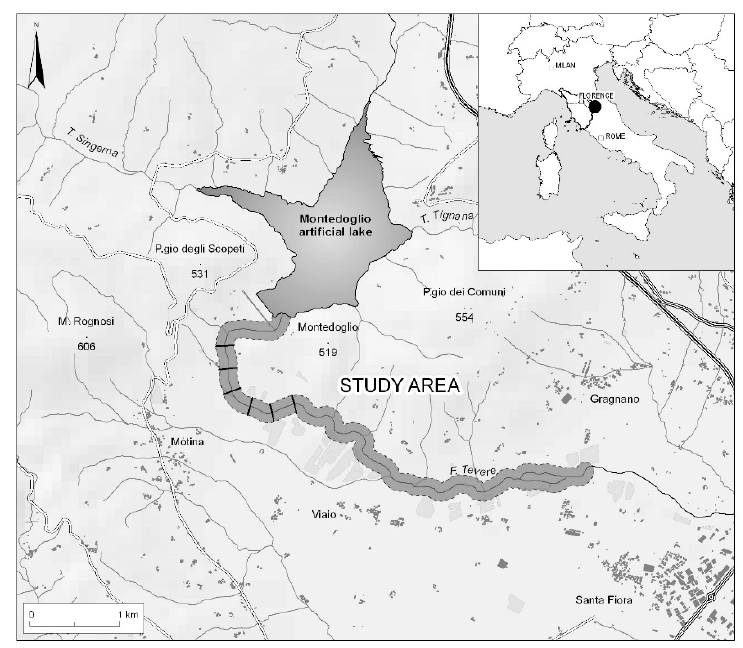
Figure 1: Location of the study area. Sampled transects are drawn as black lines. Figure 1. Location of the study area. Sampled transects are drawn as black